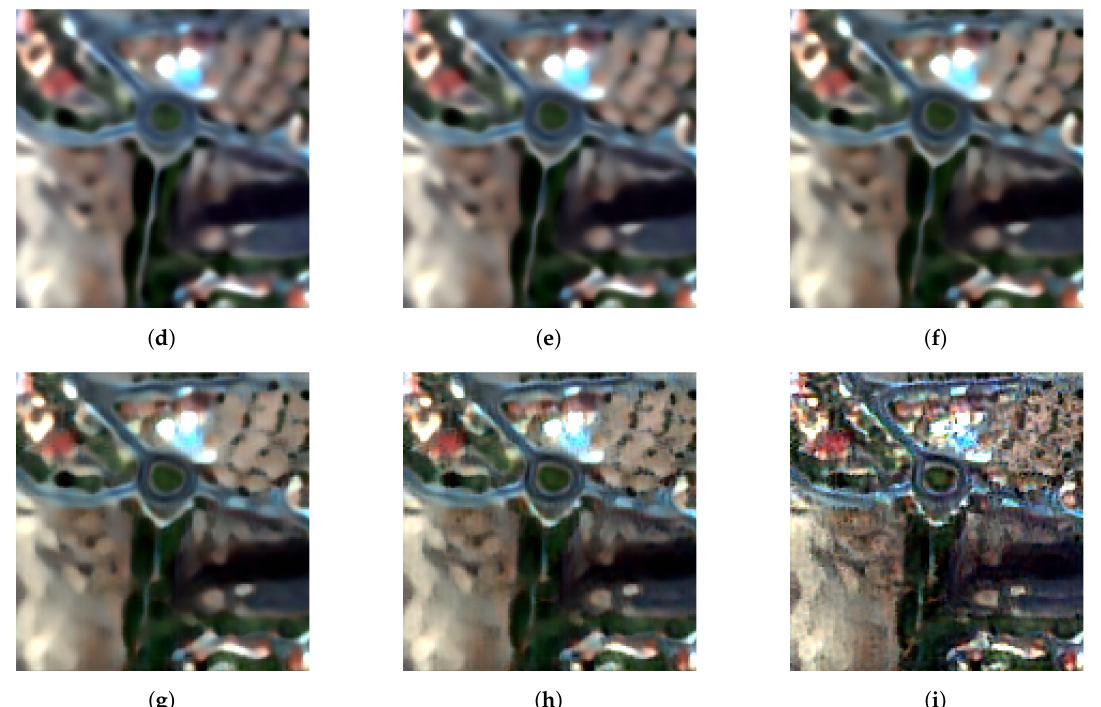
Figure 8. Results of a region of Maspalomas-2015 from W-S Set1. ( a ) HR, ( b ) LR with NN interpolation, ( c ) LR with bicubic interpolation, ( d ) SR with α = 0, ( e ) SR with α = 0.1, ( f ) SR with α = 0.2, ( g ) SR with α = 0.5, ( h ) SR with α = 0.7, ( i ) SR with α = 1. Image size: 140 × 140 pixels.